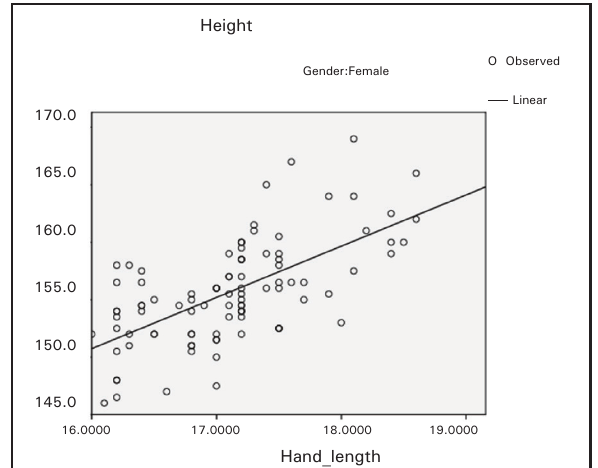
Figure 2. Regression of height on hand length for females.